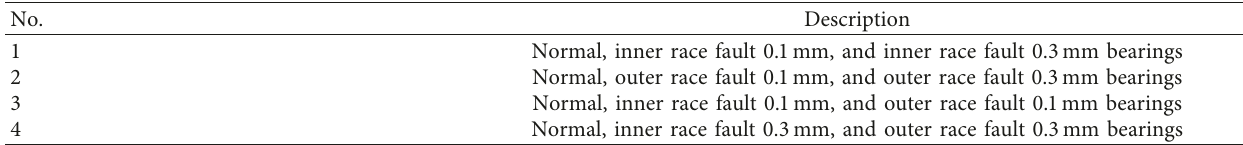
Table 5: Faulty samples divided into 4 groups